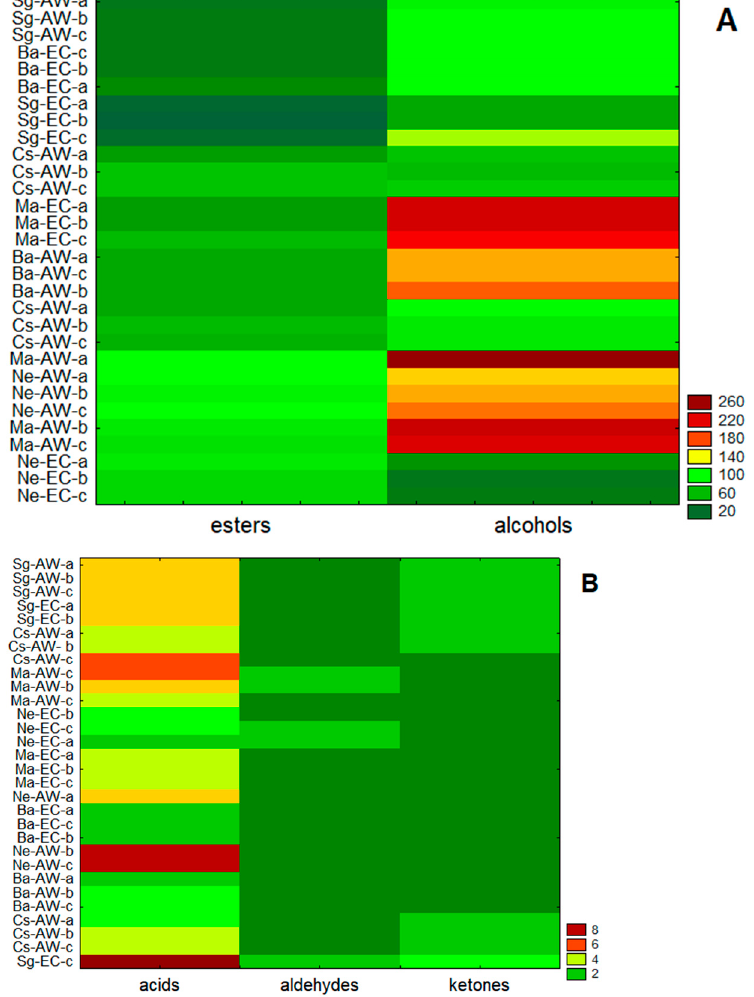
Figure 1. Two way-joining run on the total amounts (ppm) of esters, alcohols ( A ), and acids, alde- hydes and ketones ( B ). Sg, Sangiovese; Ma, Magliocco; Ba, Barbera; Cs, Cabernet-Sauvignon; Ne, Negroamaro. EC, strain EC1118; AW, strain